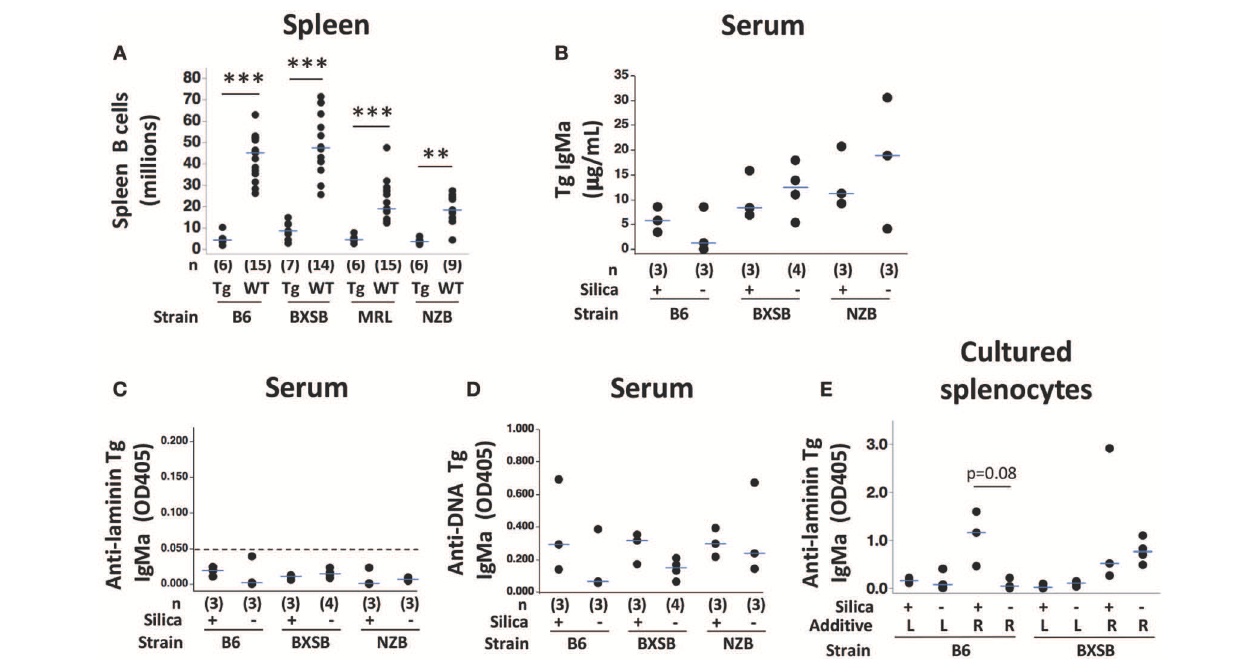
FIGURE 4 | Autoreactive B cell regulation in autoantibody transgenic (autoAb Tg) mice with or without exposure to crystalline silica. (A) Spleen CD19 + B cell numbers as determined by flow cytometric analysis in autoAb Tg and WT mice. Within an indicated strain, silica and vehicle-exposed mice are pooled for each genotype; ** p < 0.01, *** p < 0.001 for autoAb Tg vs. wildtype mice of the same strain, Wilcoxon rank sum test. (B) Serum IgMa (Tg) concentration, determined using a standard curve; (C) serum anti-laminin Tg autoAb, with cutoff for laminin-binding positivity at an OD of 0.050 indicated by the dashed line; and (D) serum anti-ssDNA Tg autoAb. Concurrent mean OD405 for positive control Tg-expressing IgM monoclonal antibodies are 0.208 for anti-laminin Ig A10C and 0.352 for anti-DNA Ig LamH/Vk8Jk5 (not shown). Antigen binding was tested in serum at 1/20 dilution in duplicate, measured as OD405 on antigen after subtraction of OD405 for binding on diluent-coated wells. (E) Level of anti-laminin Tg IgMa autoAb in supernatants of spleen cells from exposed mice stimulated 7–8 days with indicated additive: L, lipopolysaccharide (TLR4 ligand); R, R848 (TLR7 ligand) in combination with CpG oligos (TLR9 ligand). Undiluted supernatants were tested in duplicate; n = 3 mice/strain. Concurrent OD405 for positive control monoclonal antibody was 0.974 for anti-laminin H50